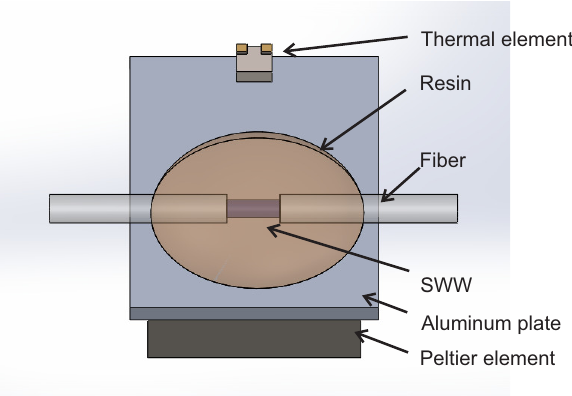
Figure 8. Experimental setup for verifying the simulated thermal behaviour of the SWWs. The interconnecting structure is written in between two multi-mode silica fibers (OM2) on top of an aluminum plate, which is heated by a Peltier element (QC-32-0.6-1.2, Quick-Cool). The actual temperature is checked with an additional thermal sensor (Heraeus Nexensos M222).